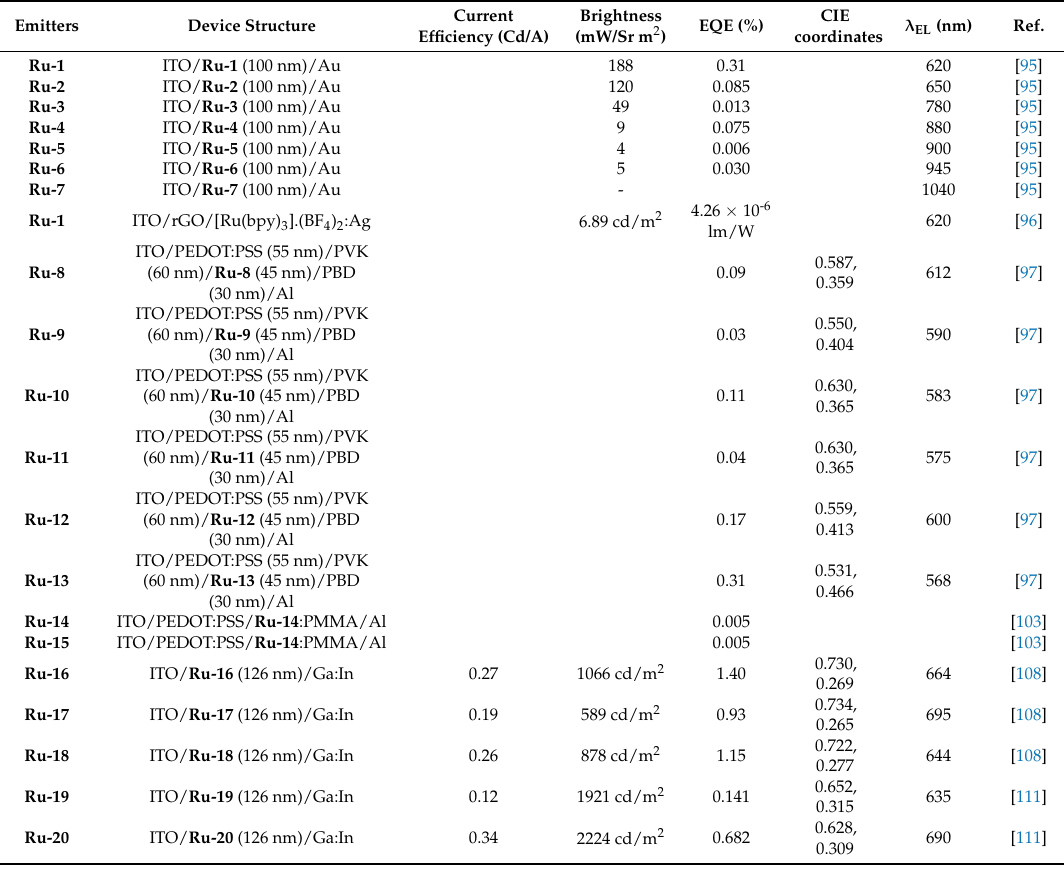
Table 4. Summary of electroluminescent properties of light-emitting electrochemical cells (LECs) and organic light-emitting diodes (OLEDs) fabricated with